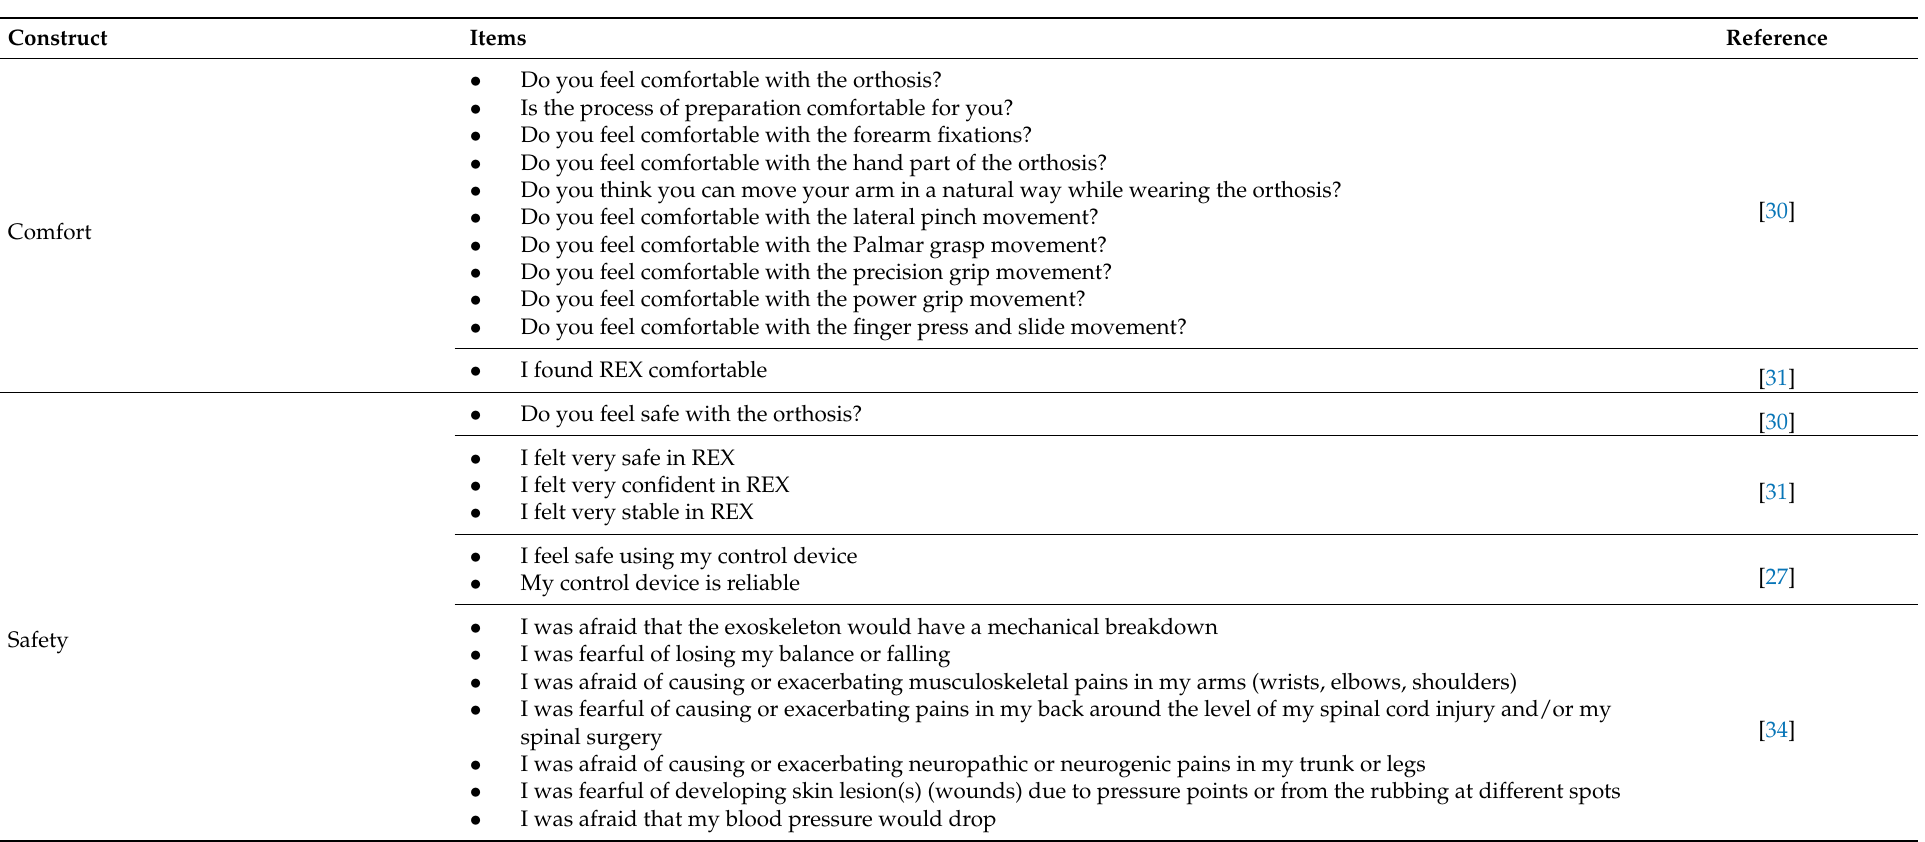
Table 2. Ad-hoc items developed by the authors to measure user